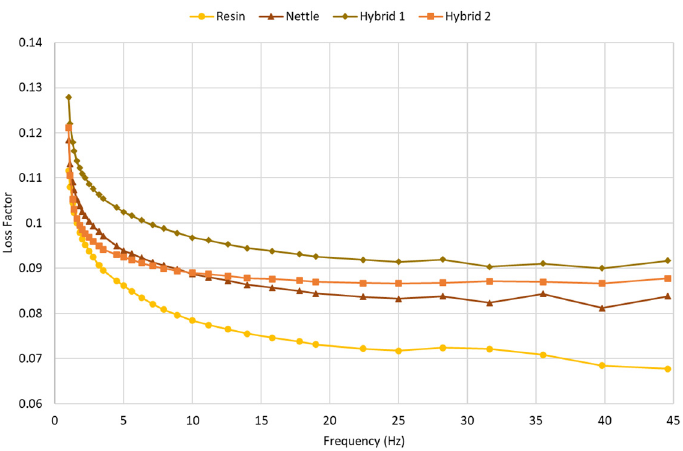
Figure 8. Variation of loss factor with frequency. Table 3. Loss factors for typical vehicle natural damped frequencies. Resin Nettle Hybrid 1